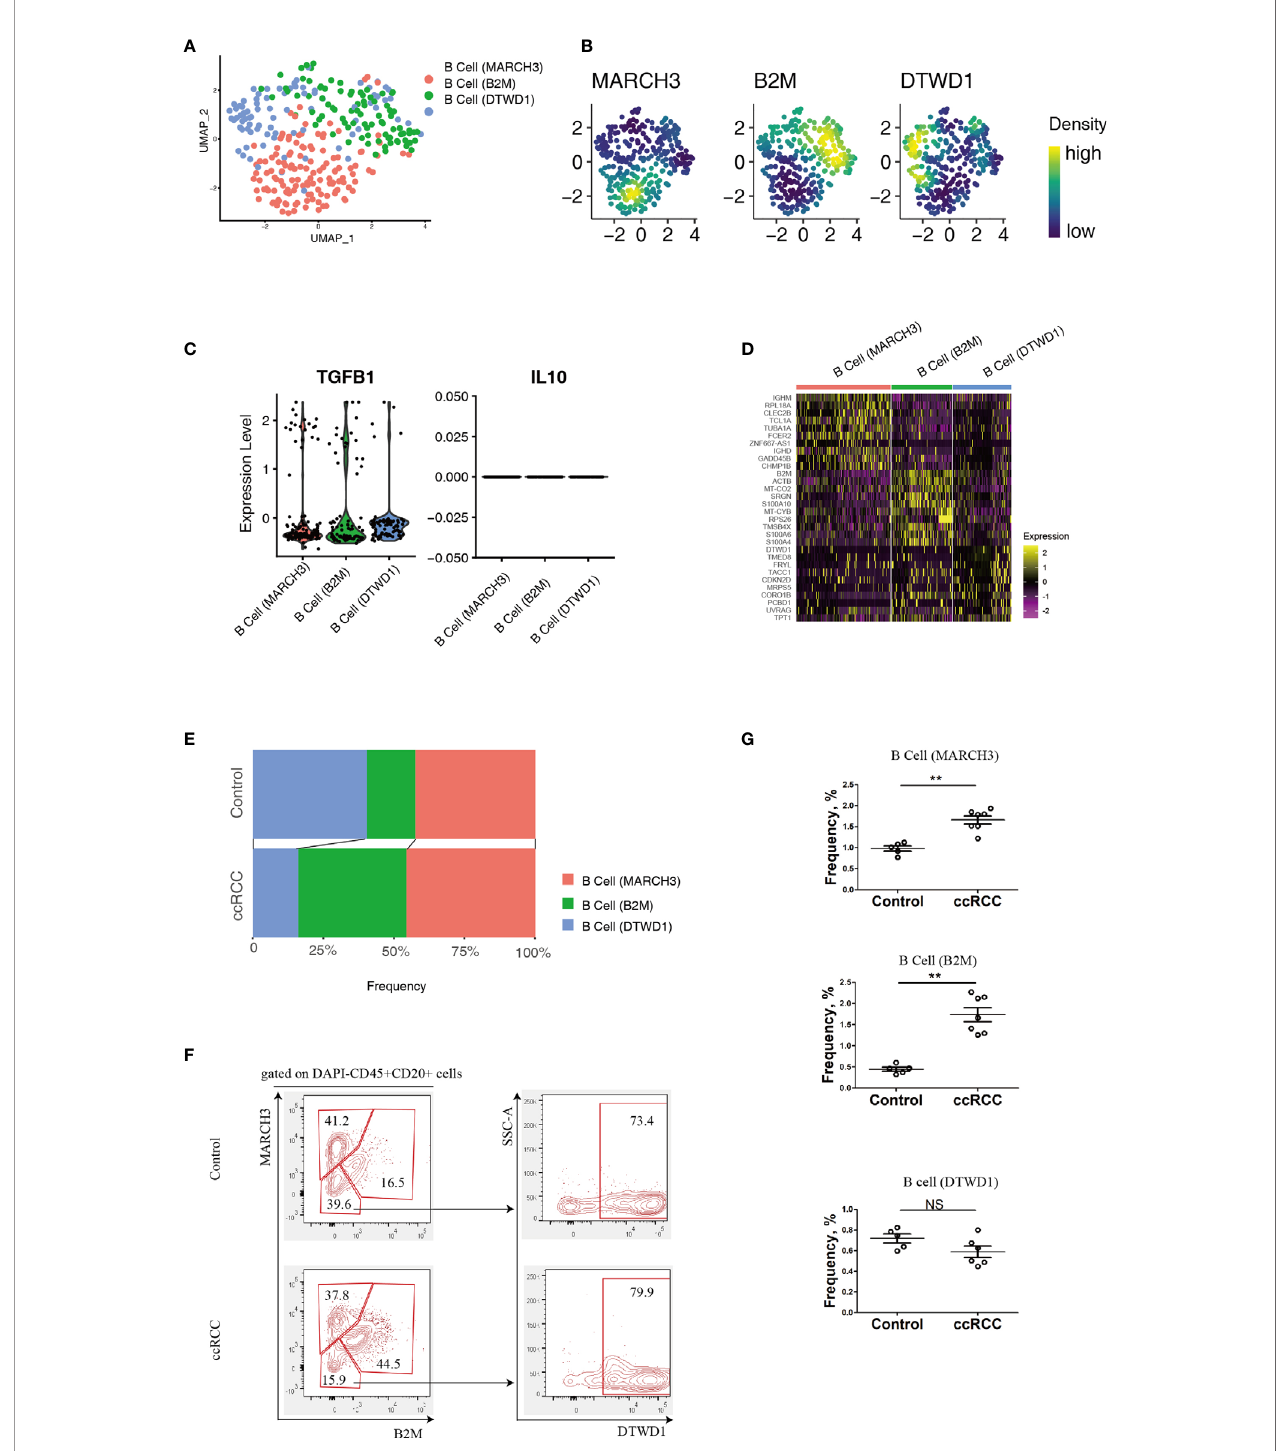
FIGURE 2 | Analysis of B cell Subpopulations By using scRNA-seq And Flow Cytometry. (A) A UMAP plot showing the subpopulations of B cells after performing integration of control kidney and ccRCC B cells. (B) Gene nebula maps showing the distribution of the three featured genes (MARCH3, B2M and DTWD1) in integrated B cells. (C) Violin plots showing the expression of TGF- b 1 and IL-10 in B cell subpopulations. (D) A heatmap showing the heterogeneity of the top 10 genes expressed among B cell subpopulations. (E) Stacked bar plots showing the comparison of B cell subpopulations in control kidneys and ccRCC biopsies. (F) Flow cytometry analysis of B cell subpopulations in control kidneys and ccRCC biopsies. (G) Scatter plots showing the statistical analysis of B cell subpopulations in control kidneys and ccRCC biopsies. Each dot represents one readout. The data represent 2 independent experiments. **p < 0.01; NS, not signi fi